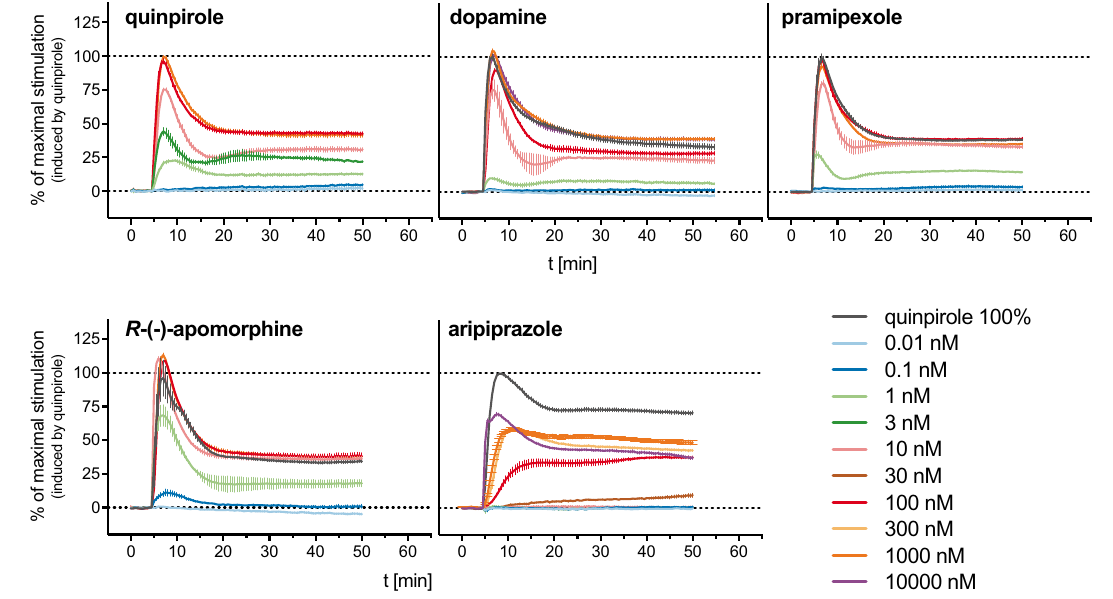
Figure 2. Representative DMR time courses of the concentration-dependent change in wavelength shift (Δλ; pm) induced by addition of the indicated reference agonists to CHO-K1 hD 2long R cells. Data were normalised to the maximum wavelength shift induced by 1 μM quinpirole (100%) and a buffer control (0%). Shown are data (means ± SEM) from representative experiments out of three independent experiments, each performed in triplicate.